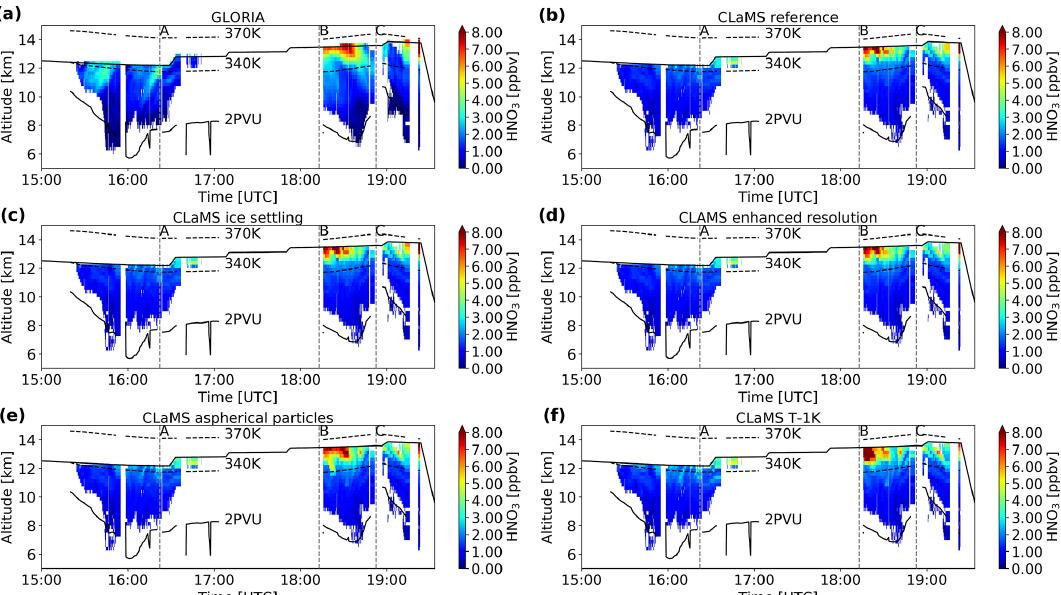
Figure B2. Cross sections of HNO 3 volume mixing ratio distribution for flight 8 on 20 January 2016 derived by GLORIA (a) and modelled by the CLaMS reference simulation (b) , and sensitivity simulations considering (c) ice formation on NAT particles, (d) temperature fluctuations, (e) growth rates of aspherical particles and (f) 1K global temperature offset. Flight altitude (bold black line), characteristic waypoints (A, B, C), 340 and 370K potential temperature levels (MERRA-2, dashed black lines), and 2PVU level (MERRA-2, black